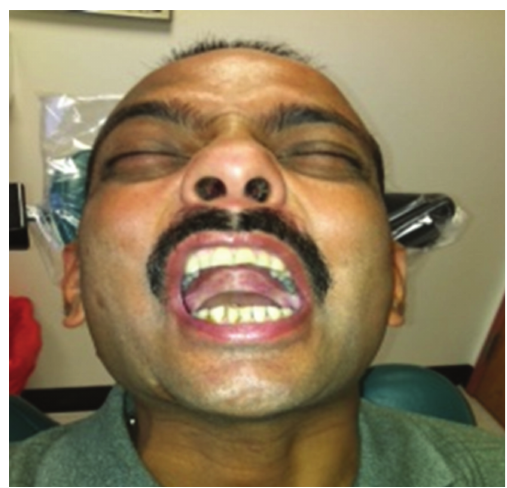
Figure 5: Sustained patient mouth opening at one year